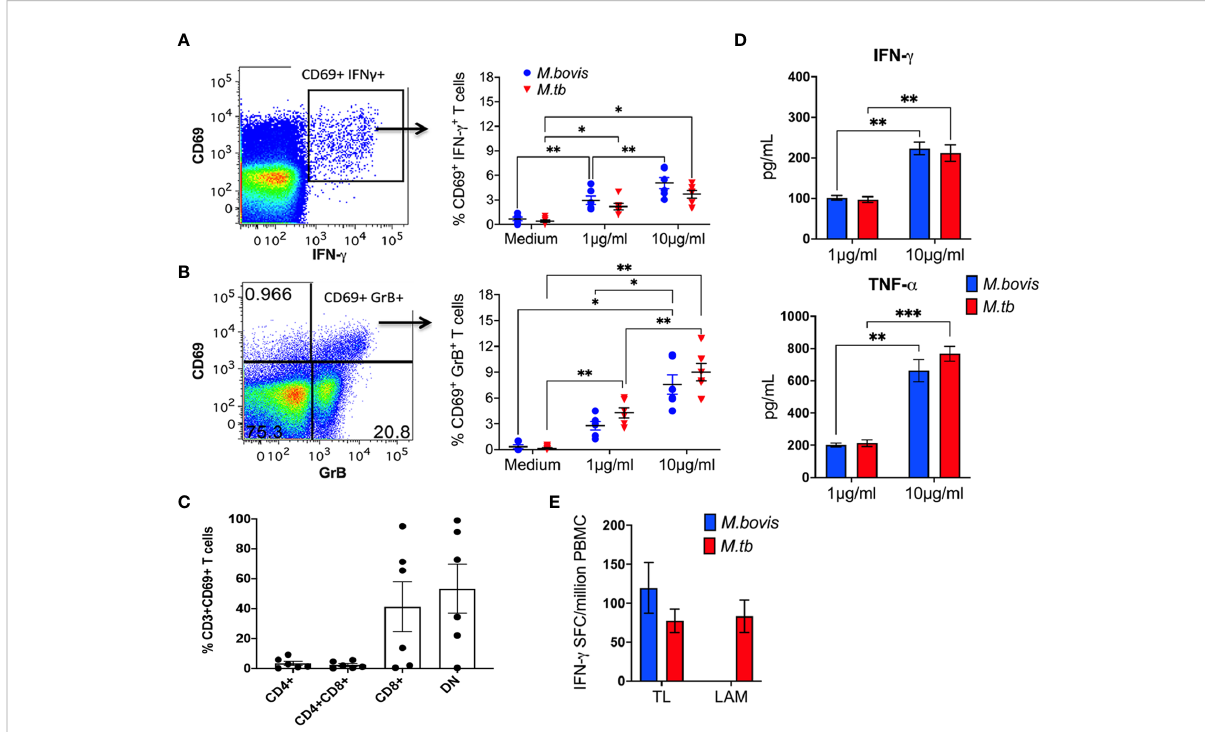
FIGURE 1 Lipid-reactive T cell functions in peripheral blood of BCG-naïve macaques. Representative fl ow cytometry plots of CD3+ T lymphocytes in PBMC showing intracellular IFN- g (A) and GrB (B) staining on recently activated CD69+ T cells. Frequencies of CD69 + IFN- g + and CD69 + GrB + cells are shown for PBMC isolated from 5 BCG-naïve macaques and stimulated for 12h with 1 m g/ml or 10 m g/ml TL fractions of M.bovis (blue circles) or Mtb (red triangles). Medium alone served as negative control. (C) CD4 and CD8 co-receptor expression denoted as CD4 + , CD8 + , CD4 + CD8 + double positive, and double negative (DN) on Mtb TL-responsive CD69+ T cells was quanti fi ed using cryopreserved PBMC obtained from 6 BCG-naïve macaques. (D) IFN- g responses following stimulation with Mtb TL and LAM (red bars) and M.bovis TL (blue bar) expressed as SFU/million PBMCs. (E) IFN- g and TNF- a ELISA showing total amounts of Th1 cytokines secreted by Mtb TL (red bar) and M.bovis TL (blue bar) reactive T cells, expressed as pg/ml. Data shows mean and SEM and are representative of two independent experiments. Doses were compared using repeated measures